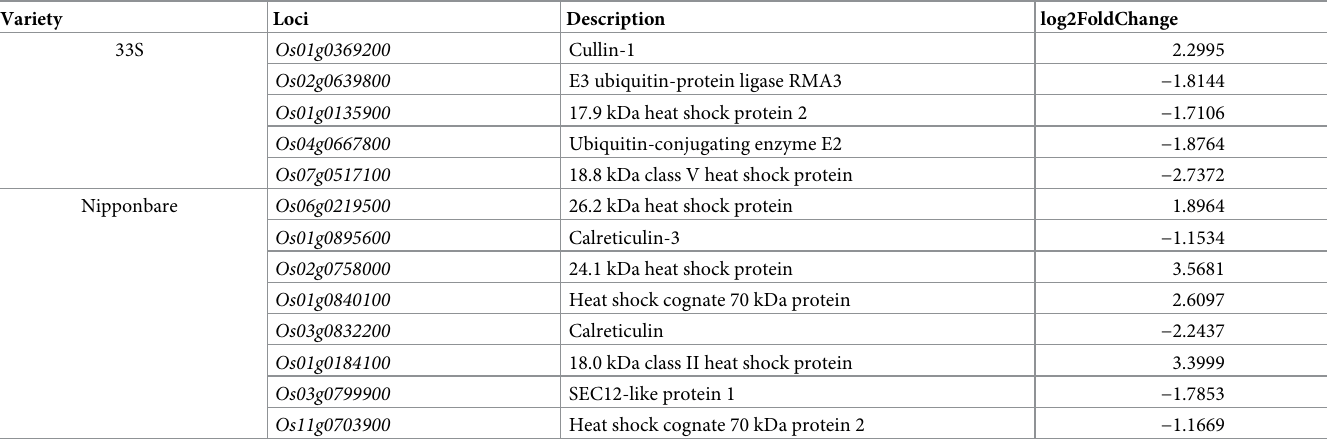
Table 2. List of DEGs enriched in protein processing in endoplasmic reticulum pathway.